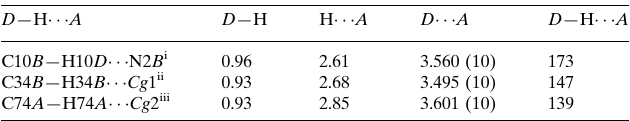
Hydrogen-bond geometry (A˚ , (cid:2)